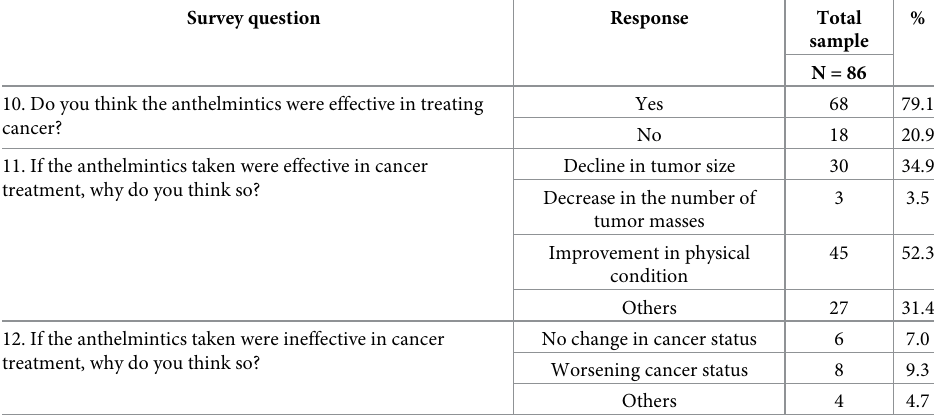
Table 3. Perceptions on the antitumor efficacy of